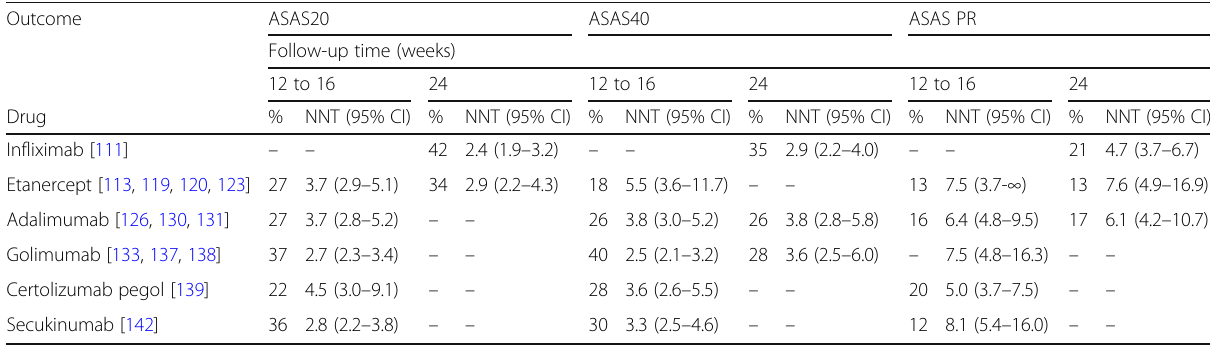
calculated using a normal approximation compared to the placebo. - Data were not reported in the studies. Data from different studies were pooled when the same outcomes from the same treatments were available and when they referred to doses